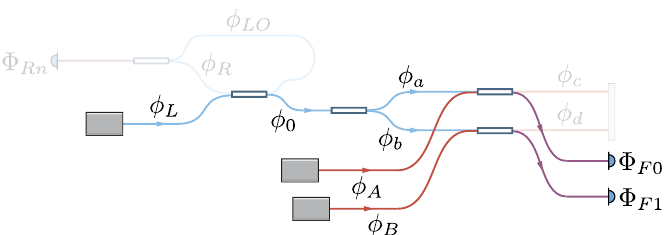
Figure 2. Forward path phase contributions from each unique length of fiber in the optical system. For clarity, only two fibers are shown.